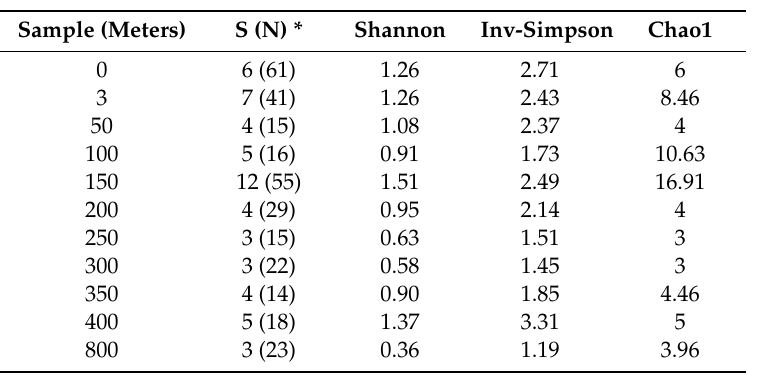
Table 1. Indices and richness estimator ( α -diversity) for the correlated sampled points in meters from the retreating Collins